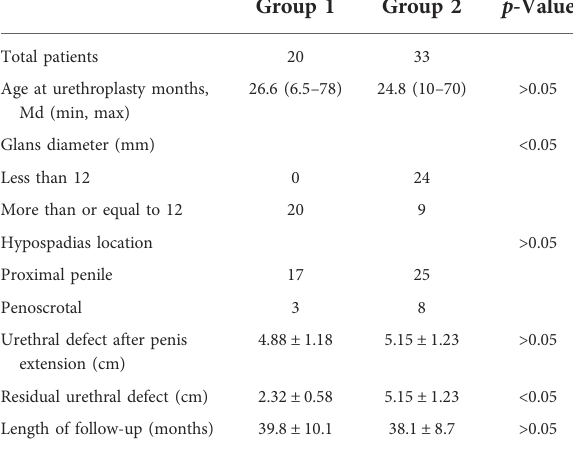
TABLE 1 Characteristics of patients. TABLE 2 Surgical